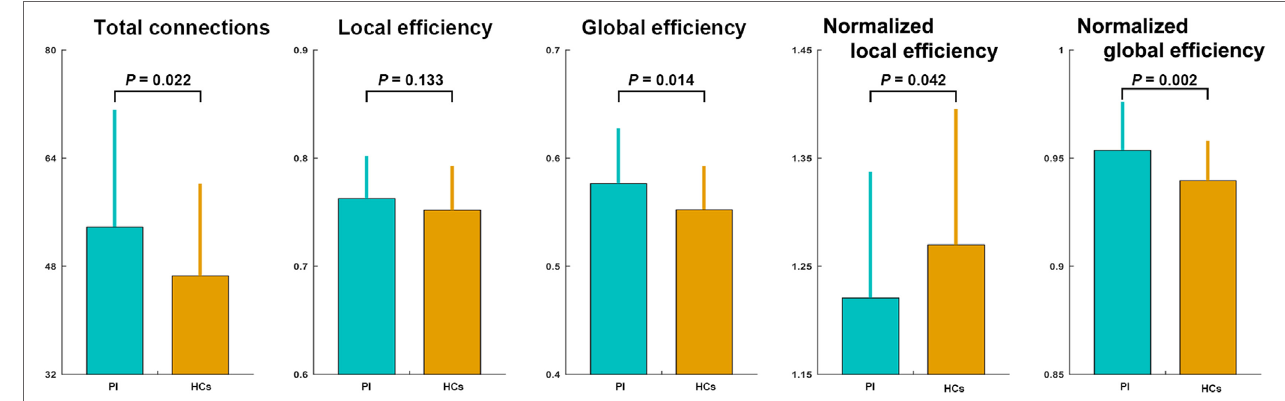
FigUre 1 | Between-group differences in total number of connections and network efficiency of functional brain networks. Patients with PI had significantly higher total connections ( P = 0.022), global efficiency ( P = 0.014), and normalized global efficiency ( P = 0.002), and lower normalized local efficiency ( P = 0.042) compared with controls. Error bars denote mean and SD. PI, primary insomnia; HCs, healthy